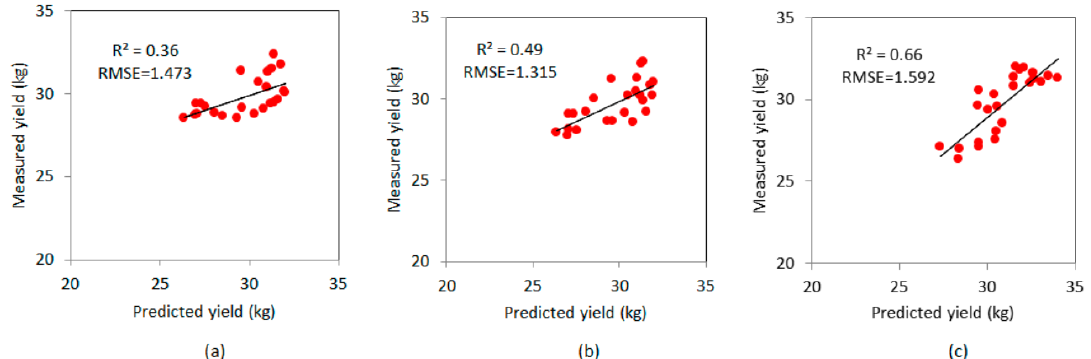
Figure 5. Estimation results of the ramie yield by using the multiple linear regression model and stepwise linear regression models. ( a ) Stepwise linear regression model only including the plant number, ( b ) stepwise linear regression model including the plant number and plant height, and ( c ) the multiple linear regression